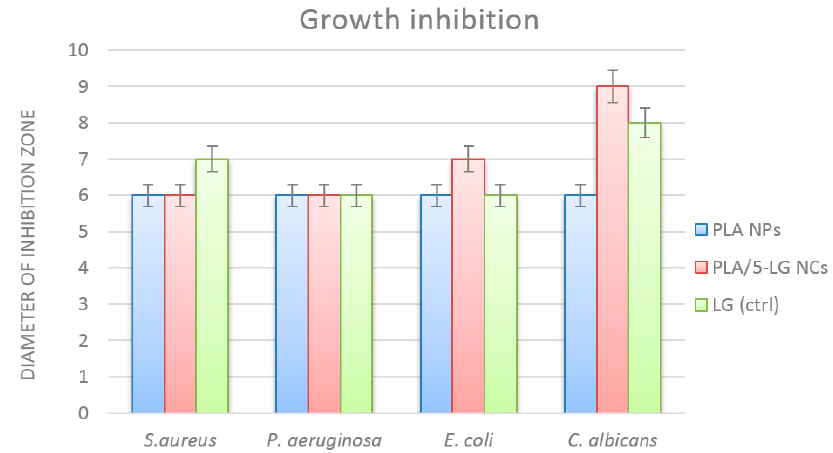
Figure 5. Graphic representation revealing the growth inhibition diameters of tested microbial strains grown in the presence of PLA NPs, PLA/5-LG NCs and control LG.